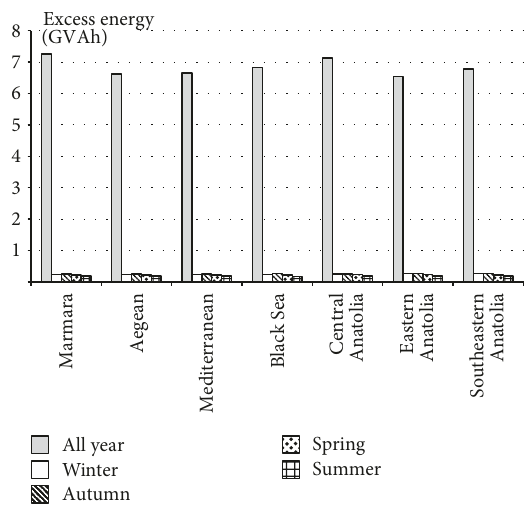
Figure 6: Excess energy produced by PV